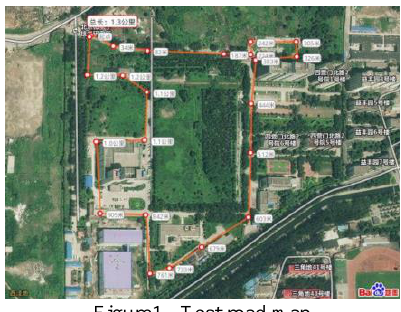
Figure1. Test road map